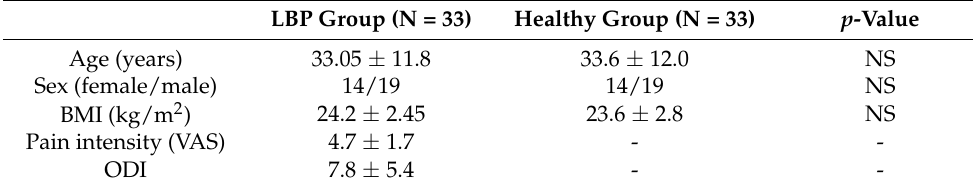
Table 1. Demographic characteristics of the